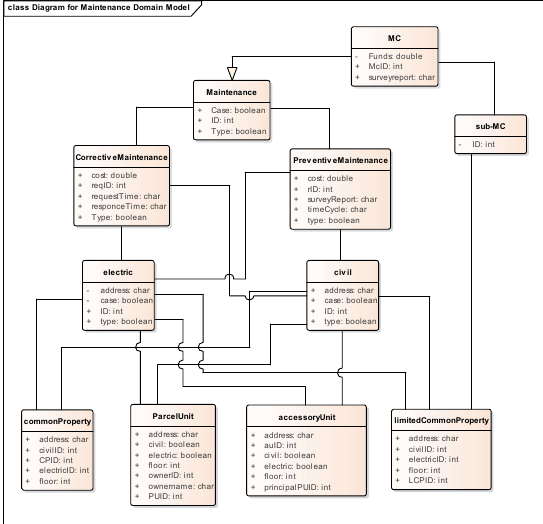
Figure 4. Maintenance Domain Model